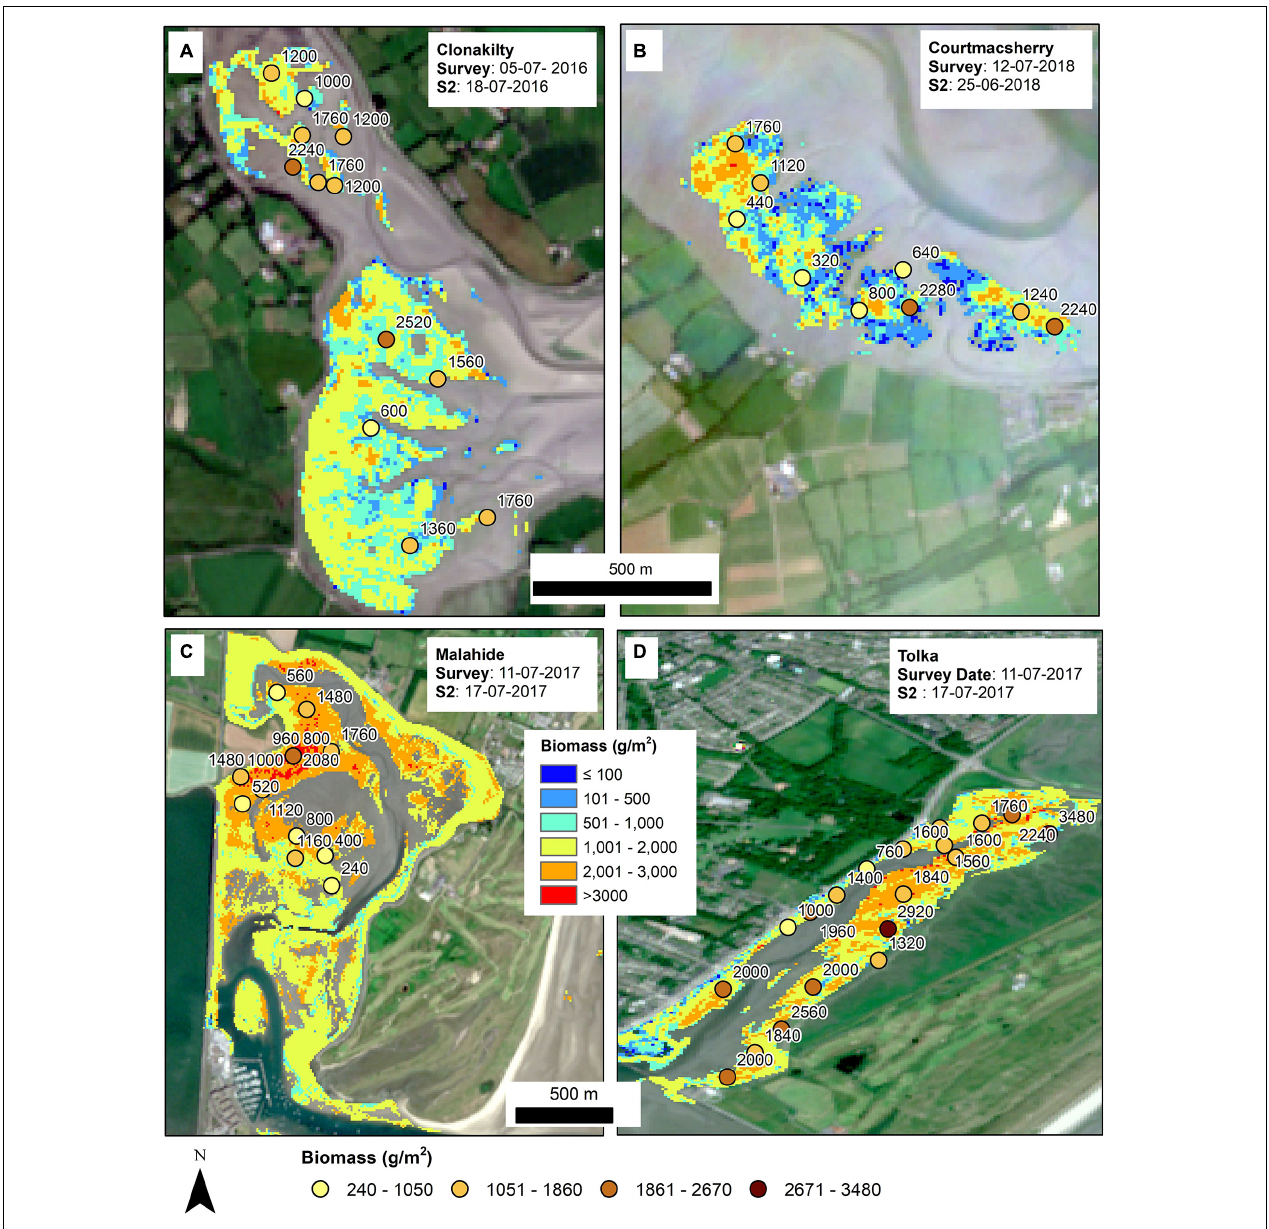
FIGURE 9 | Biomass distribution for four estuaries: (A) Clonakilty, (B) Courtmacsherry, (C) Malahide, and (D) Tolka. The field measured samples from the in situ survey are shown as points. The dates of field survey and Sentinel-2 acquisitions are also